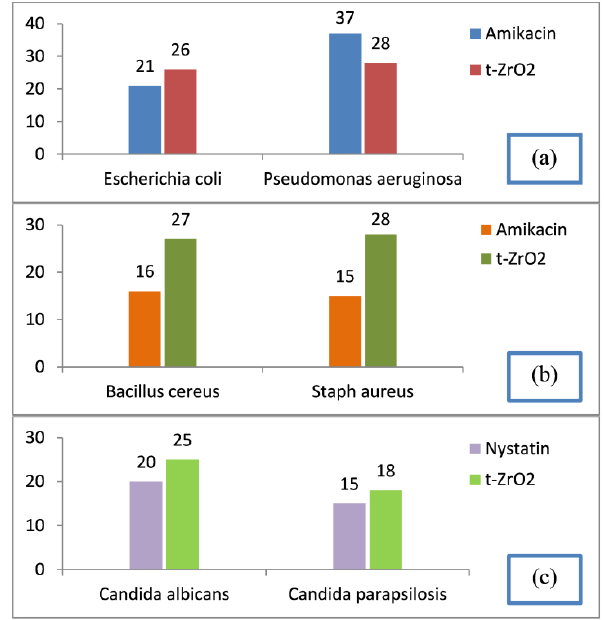
Fig. 14. Antibacterial and Antifungal activity of